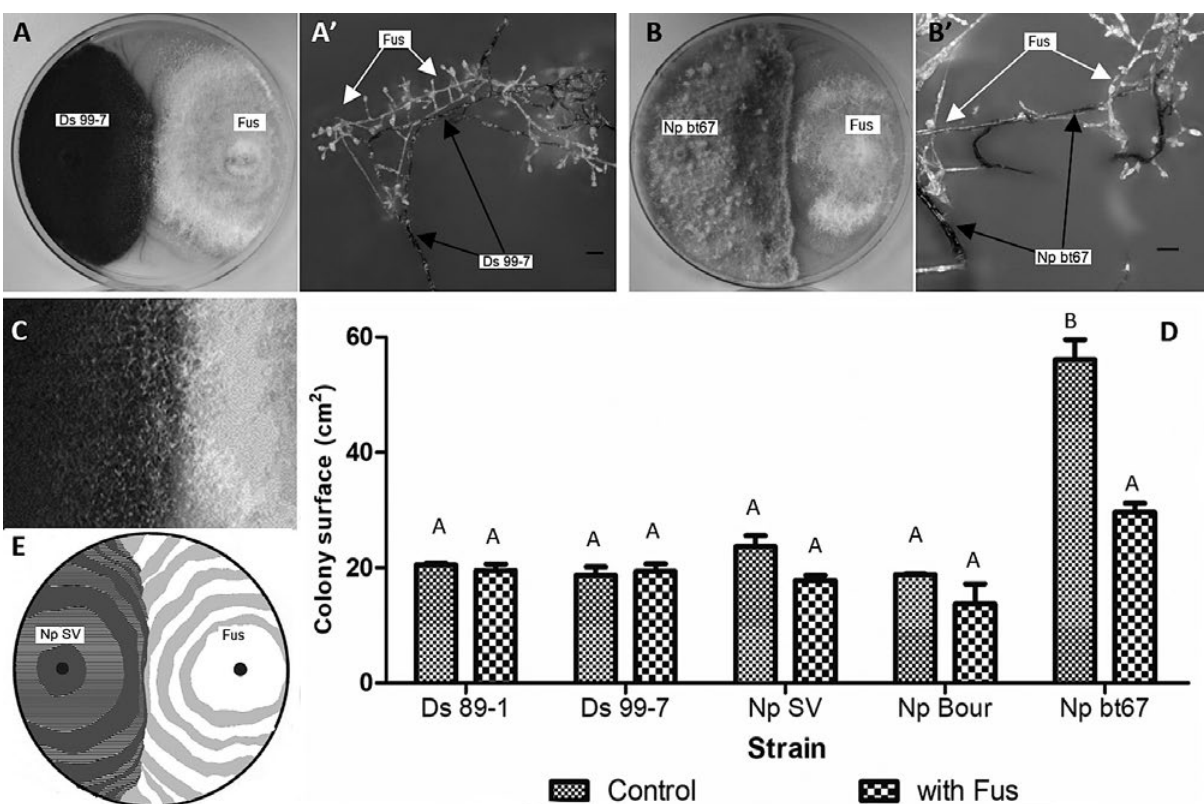
Figure 2. In vitro biocontrol activity of Fusarium proliferatum strain Fus on the tested Botryosphaeriaceae in dual culture tests. In A and B the limited growth of Ds99-7 and Np bt67 strains was noted after 4 - 7 d of dual inoculation with F. proliferatum . In A’ and B’, the respec- tive zones of confrontation, observed with a microscope, often showed intertwining hyphae of the two strains (indicated by arrows). In C, the Fus strain are growing as white flocks over the Botryosphaeriaceae, as observed at 10 dpi. In D, the mean colony surface (in cm 2 ± SE; two-way ANOVA + Bonferroli test), of the five strains compared to the controls and recorded on the day when the colonies touched, as cal- culated using a graphical representation of the co-cultures (E). Scale bars = 20μm. dpi = day post inoculation. Columns accompanied by the same letter are not significant different ( P ≤